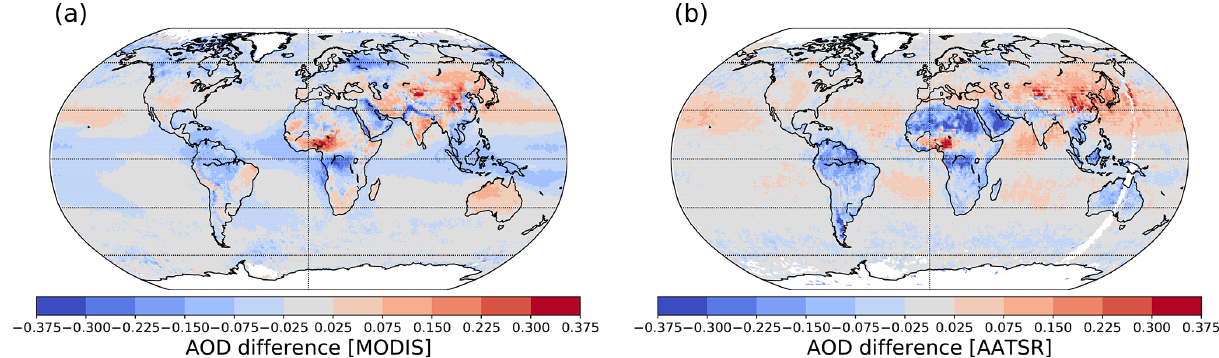
Figure 13. Annual mean AOD difference between the NEWSOA and (a) MODIS retrievals and between the MODIS and (b) AATSR retrievals. Blue and red indicate underestimation and overestimation, respectively. White areas indicate missing data in both of the